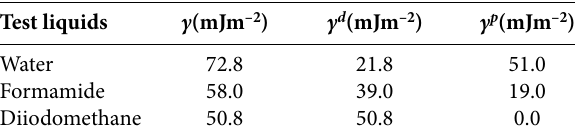
Table 2 . Surface free energy ( γ ), dispersion ( γ d ) and polar compo- nents ( γ p ) of surface free energy of test liquids used for contact